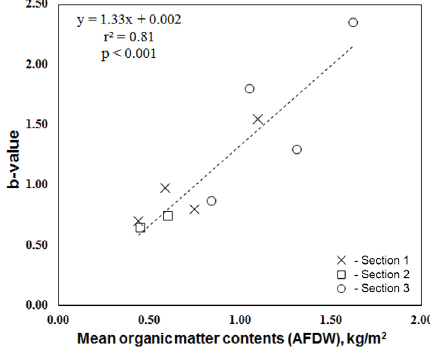
Fig. 3. b-Values (sediment oxygen demand = a (oxygen concentration) b θ (temp.-20) versus mean organic matter contents in the upper 3 cm of the sediment.